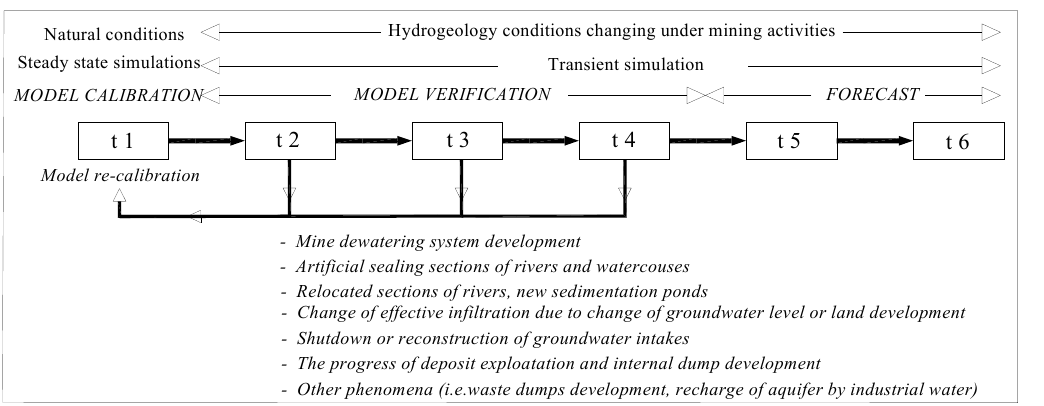
Water 2019 , 11 , x FOR PEER REVIEW 8 of 17 transient condition (if available) to improve the estimated values of the hydrogeological parameters (Figure 4).